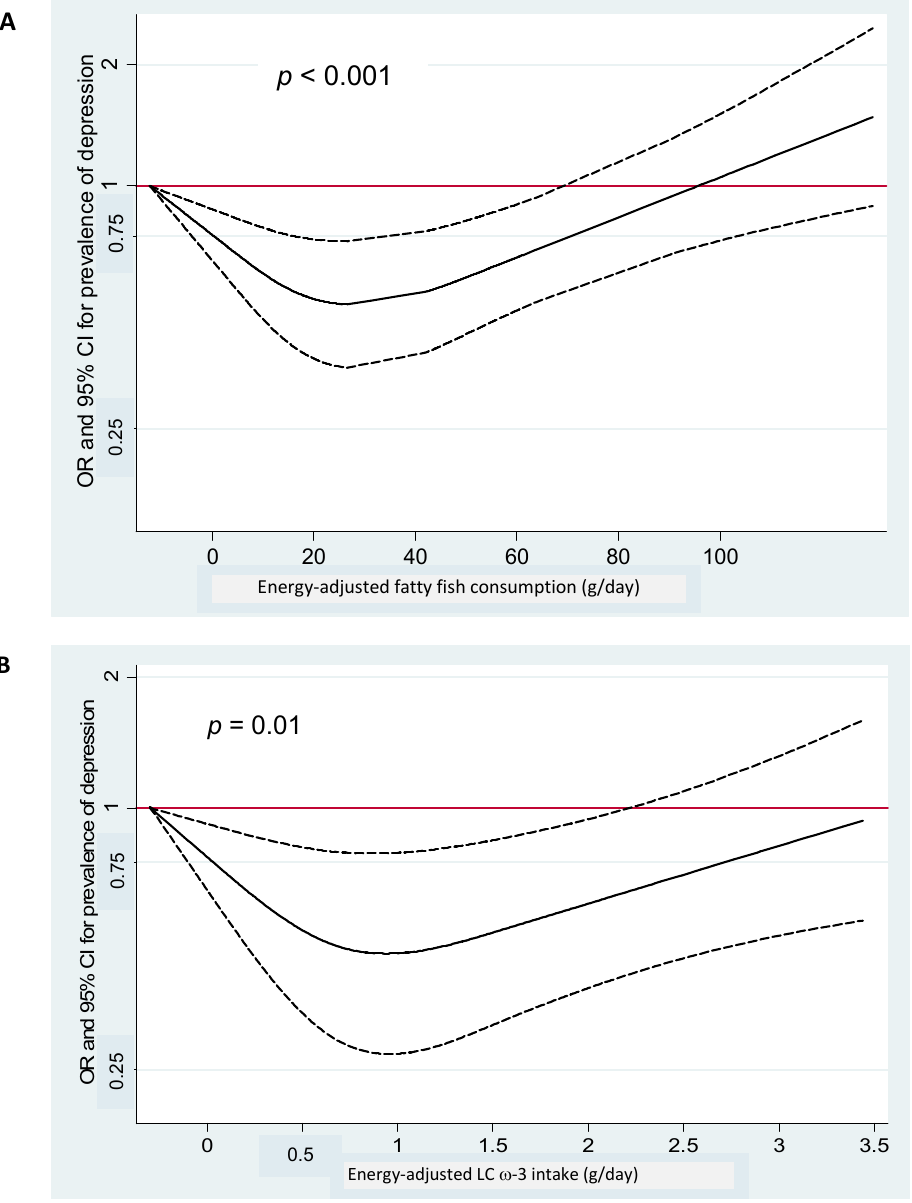
Figure 1. Spline regression models. ( A ) Spline regression model of the odds ratio of depression according to fatty fish consumption (the dotted lines represent 95% CI). ( B ) Spline regression model of the odds ratio of depression according to LC ω-3 PUFA intake (the dotted lines represent 95% CI). Table 4. Scores in the Beck Depression Inventory-II according to quintiles of consumption of fish/seafood or long-chain omega-3 fatty acids in the PREDIMED-Plus trial.